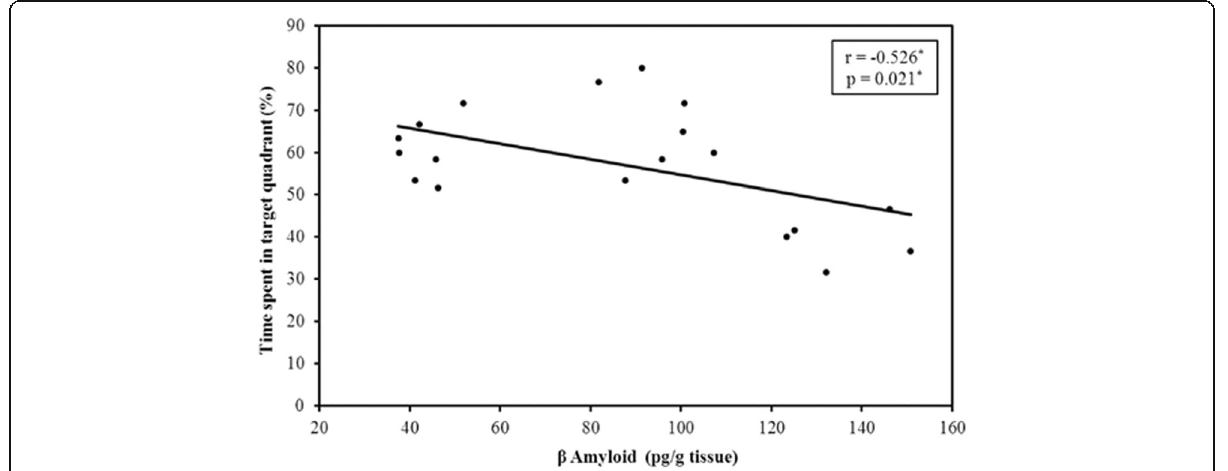
Fig. 4 Correlation between A β 1-42 (pg/g tissue) and the time spent in target quadrant (%) in the total samples (groups I, II, and III)